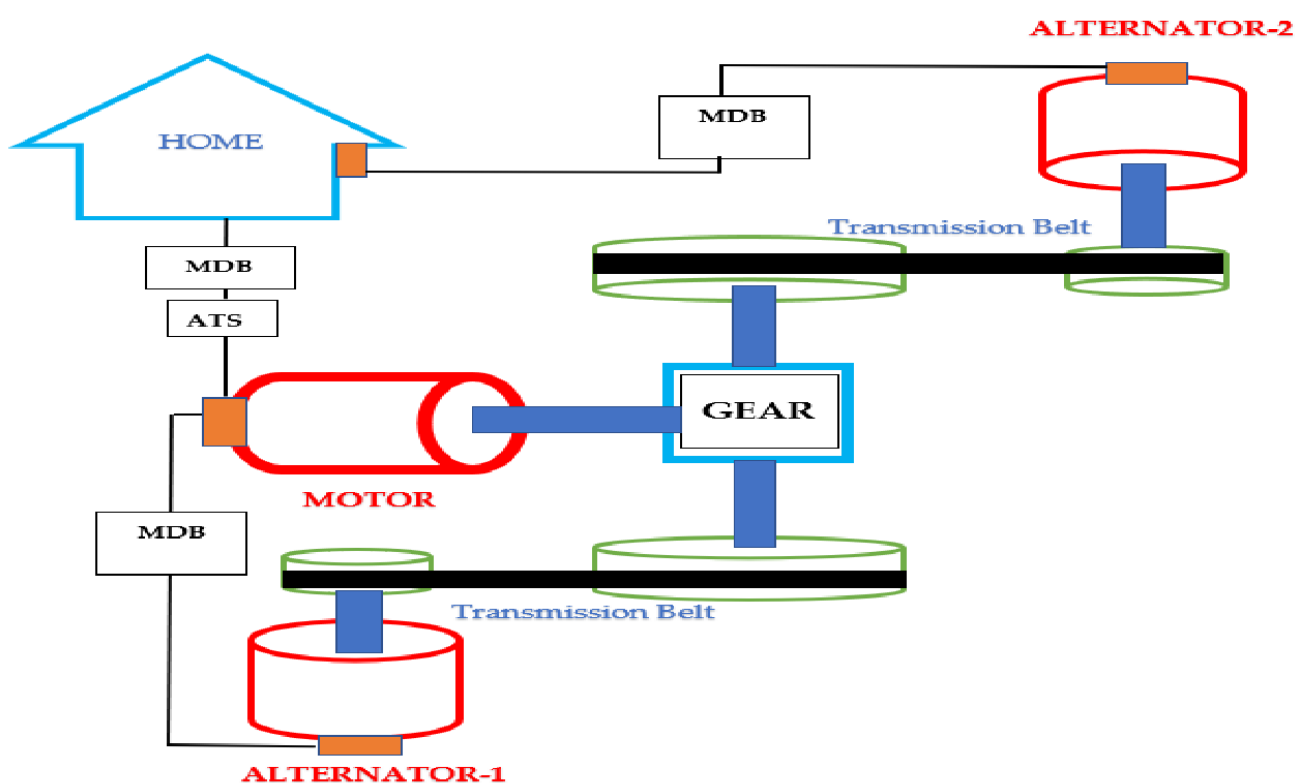
Figure 2. Axle shaft connection diagram between motor and generator with gearbox system.